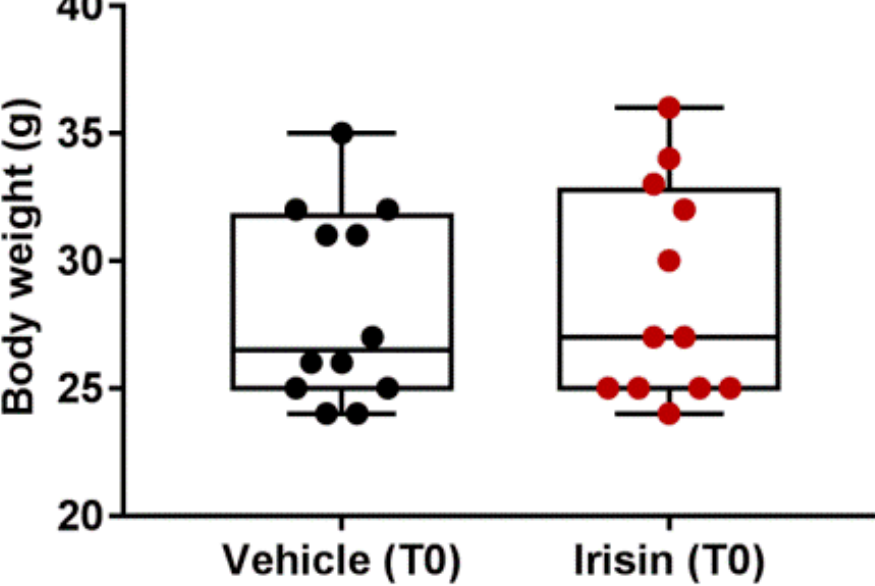
Figure 7. Body weight comparison between vehicle and irisin group before treatment (T0). Shapiro– Wilk test and unpaired two-tailed Student’s t -test were used for statistical analysis. Data are presented as box-and-whisker with median and interquartile ranges, from max to min, with all data points shown. n = 12 mice per